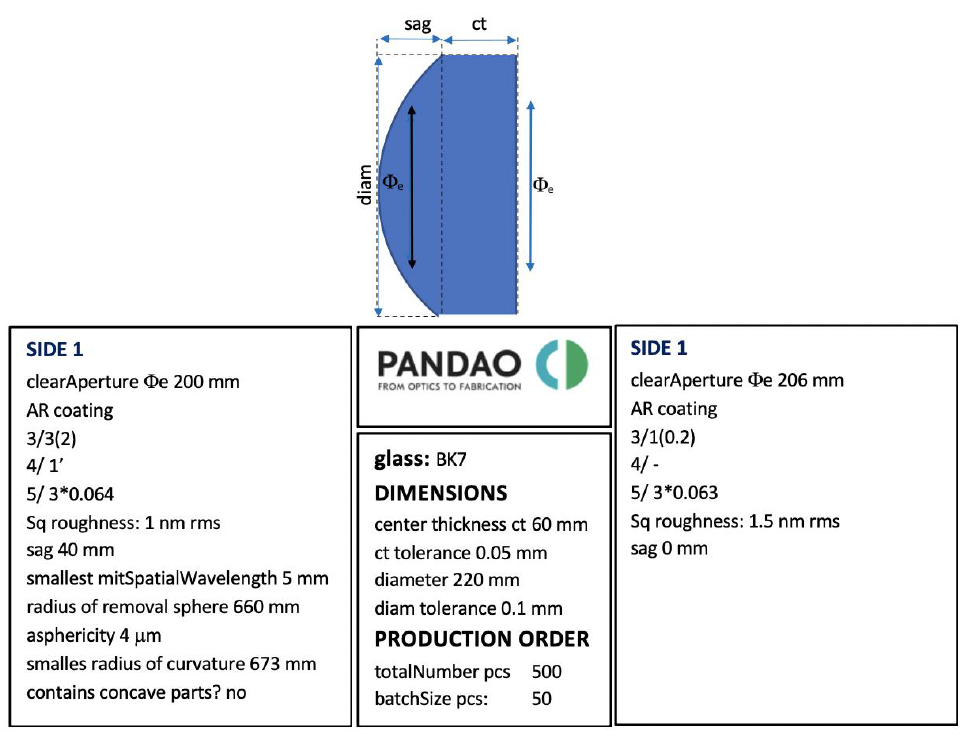
Fig.1. Plano-aspherical BK7 lens with 500 pieces to be produced: to be analized by PanDao software tool